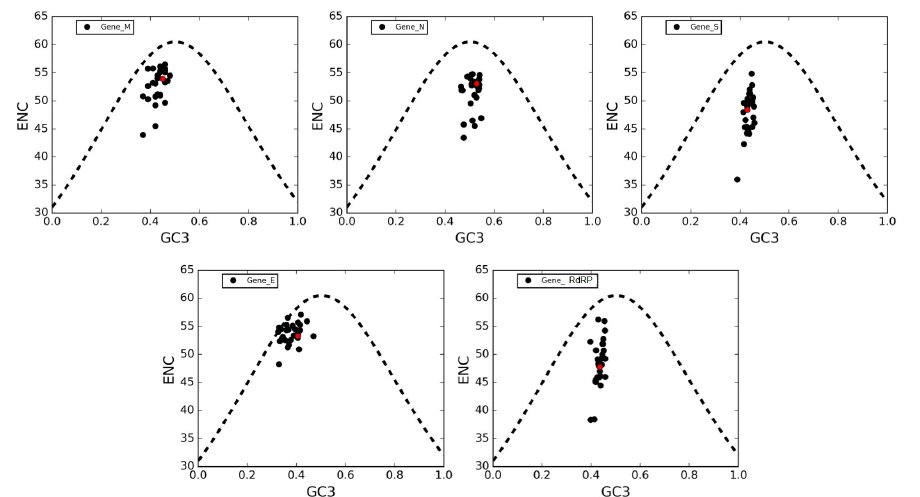
Figure 5. ENC-plots of genes M, N, S, E and RdRP . In these plots, each point corresponds to a single gene. The black-dotted lines in all panels are plots of Wright’s theoretical curve corresponding to codon usage biases (CUBs) that occur merely due to mutational bias (no selective pressure). Red dots represent SARS-CoV-2 genes.